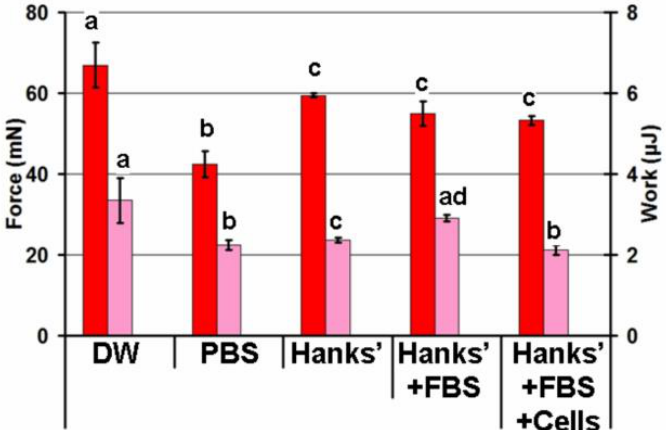
Figure 5. Effect of the composition of the adhesion medium on the adhesion strength and work of adhesion of the FeP hydrogel. A total of 0.1 mL of distilled wate r (“DW”), PBS, Hanks’ solu tion, Hanks’ solution supplemented with 10% fetal bovine serum (FBS), and Hanks’ solution s upple- mented with 10% FBS and peritoneal leukocytes (5 × 10 6 cells/mL) were placed between the serosa and the hydrogel during the adhesion test. Different lowercase letters indicate significant differ- ences among the means of the adhesion strength in different compositions of the adhesion medium or the means of the work of adhesion in different compositions of the adhesion medium ( n = 8, p < 0.05). The red and pink bars show the adhesion strengths and work of adhesion, respectively.